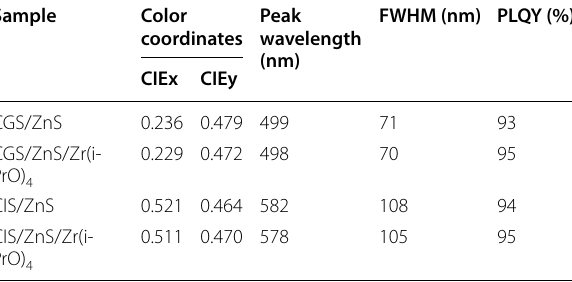
Table 1 Detailed optical properties of four QD solutions